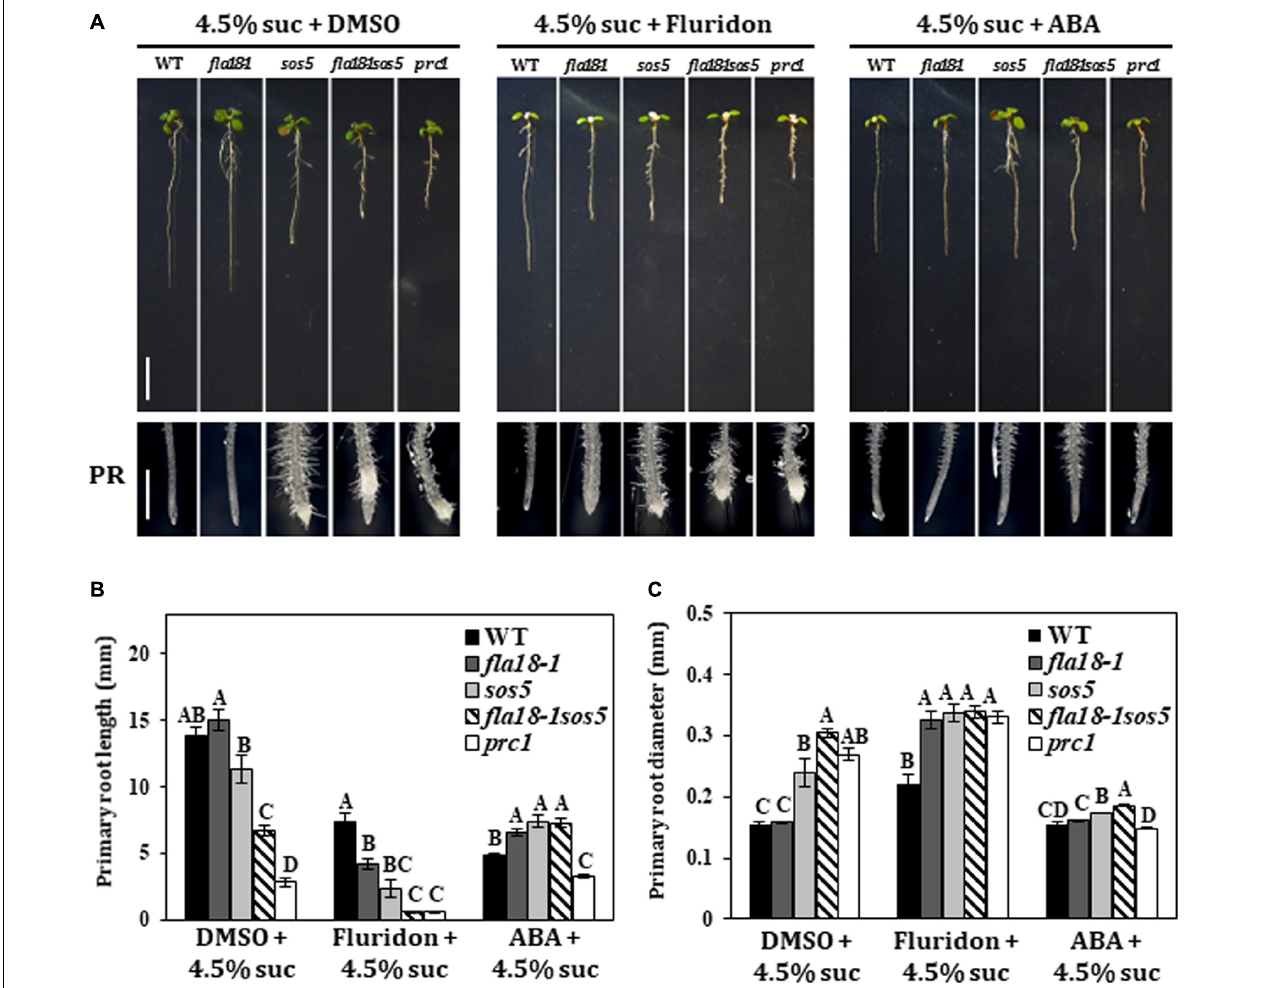
FIGURE 4 | Root elongation in fla18 and fla18sos5 is suppressed by ABA and hypersensitive to the ABA-synthesis inhibitor, Fluridon. (A) Seedlings of the indicated genotypes were grown on MS medium with 1% sucrose, for 5 days, and then transferred to medium containing 4.5% sucrose and either 5 mM ABA, 5 mM Fluridon or similar volume of DMSO, the ABA/Fluridon solvent. (B,C) Measurements of primary root length (B) and diameter (C) were conducted 48 h after seedlings were transferred to new media. The results were analyzed using JMPpro13 for statistical analysis and run through Tukey’s HSD test ( p < 0.05 ); n = 6. Error bars represent SE. Scale bars = 1 cm ( A ; upper panel) and 1 mm ( A ; lower